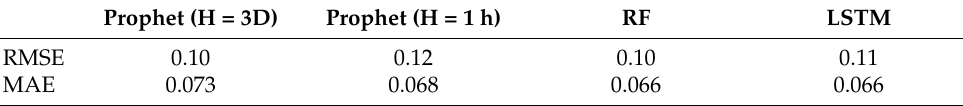
Table 2. Performance metrics of different algorithms’ comparison for the normalized virtual aggregate. Prophet (H = 3D) Prophet (H = 1